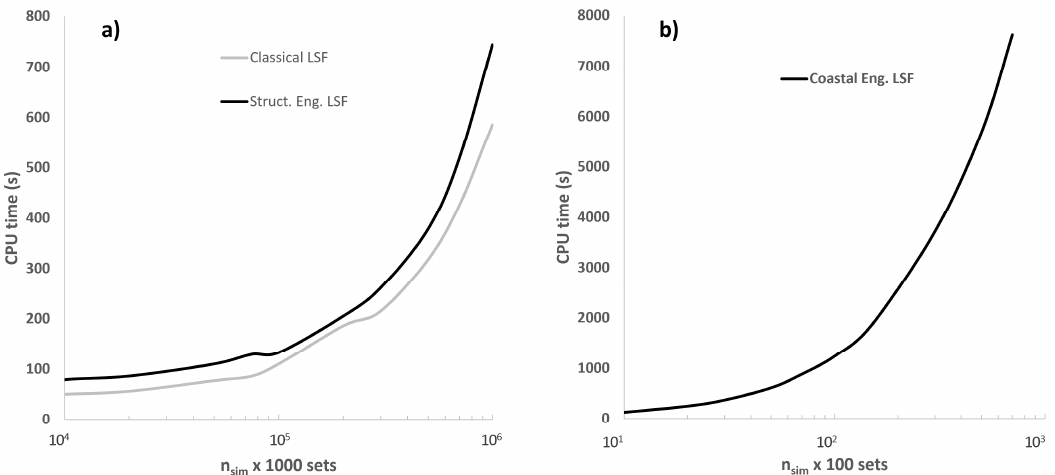
Figure A2. Computing (CPU) time for the different LSFs; ( a ) classical and RCB LSFs and ( b ) overtopping LSF.